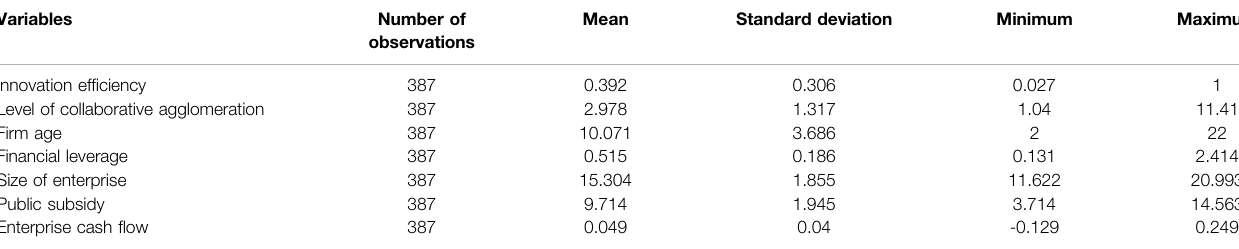
TABLE 1 | De fi nitions and summary statistics of